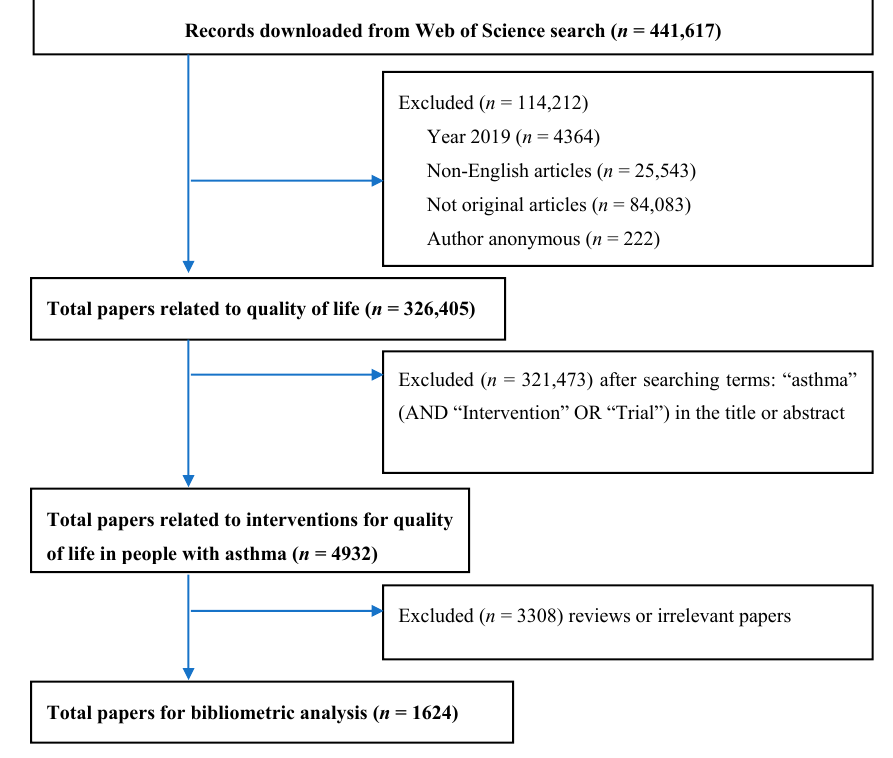
Figure 1. Selection of papers.